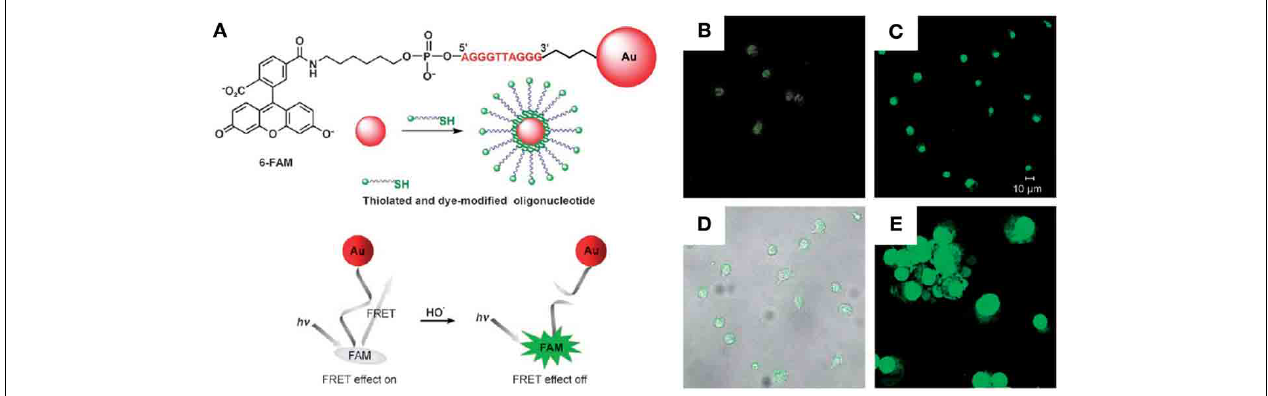
FIGURE 3 | Fluorescent-AuNPs. (A) Chemical structure of a FAM–DNA–AuNP and schematic illustration of its FRET-based operating principles. (B–E) Confocal fluorescence and phase-contrast images of living cells. (B) Fluorescence image of macrophages incubated with the probe for 30min at 37 ◦ C. (C) Fluorescence image of probe-stained